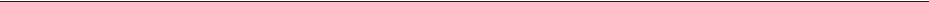
X wt (Fig. 2e), and a mere 9 hypothalamic genes downregulated in X wt /X wt vs. X wt /Y were commonly reduced in placental X ogt vs. X wt /X wt (Fig. 2f). The marked masculinization of hypotha-